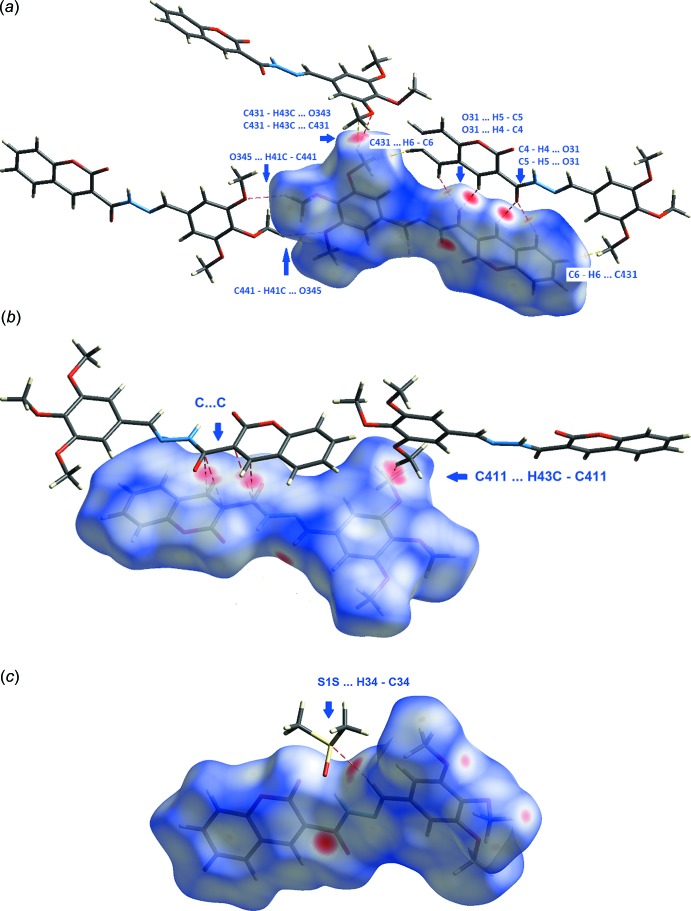
Hirshfeld surface views for [4: R = 3,4,5-(MeO)3C6H2·0.5DMSO]. The red areas on the surfaces correspond to close contacts. In (a) the site of a close H6⋯C431 contract is indicated: H6⋯C431i = 2.85 Å (sum of contact radii = 2.90 Å) [symmetry code: (i) 1 − x, −y, 1 − z].